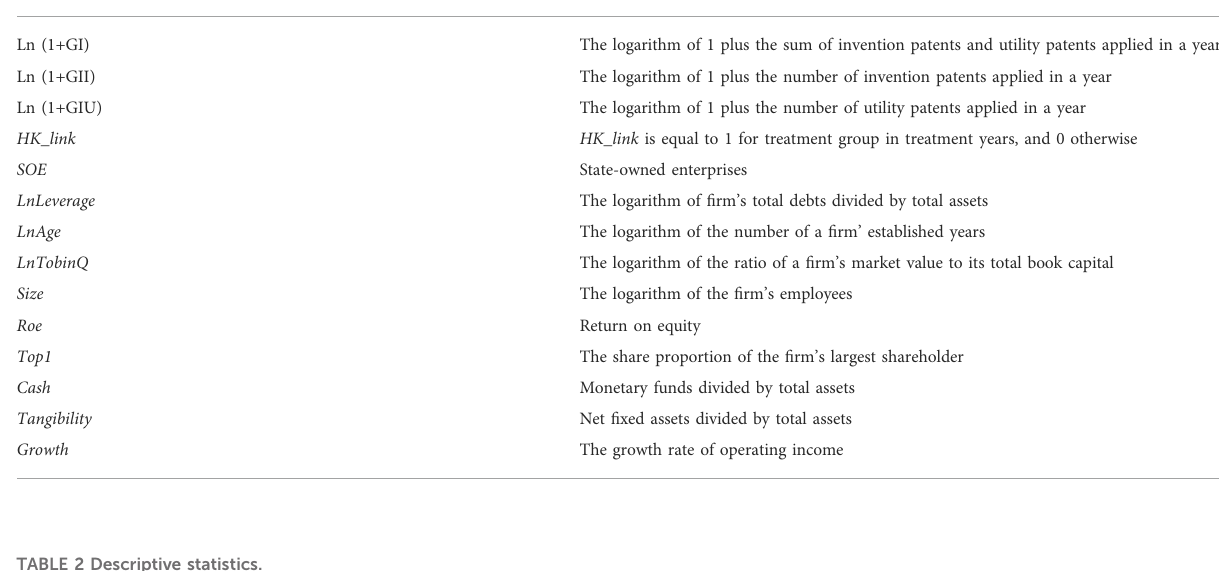
TABLE 1 Variable de fi nitions. Variable